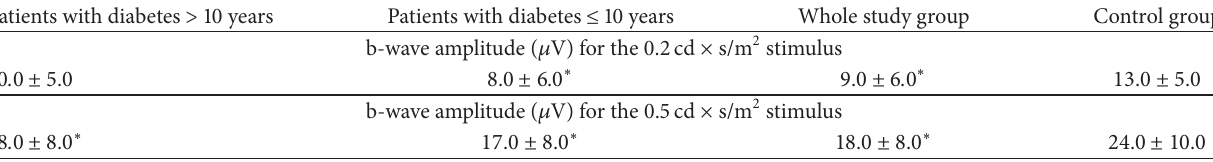
Table 2: Comparison of b-wave amplitudes in S-cone ERG of the eyes of patients in all study